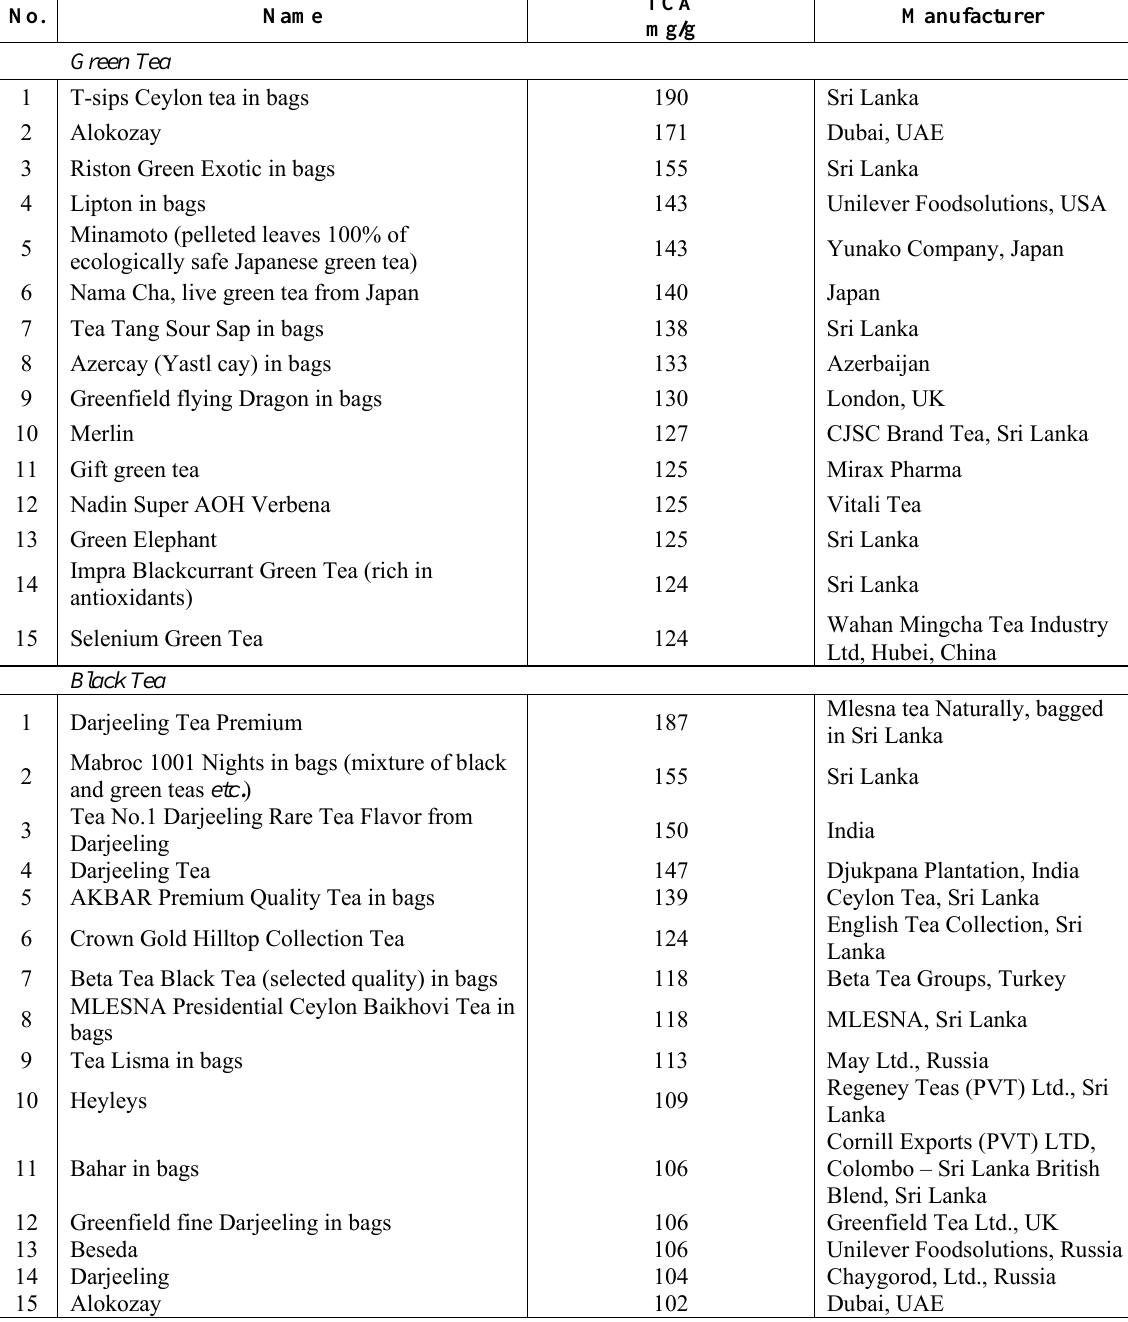
Our databank contains TCA-related data for all kinds of tea: green, oolong, black, and puer [18]. In Table 8 are presented TCA data for green and black teas. Table 10 includes data for TCA content in coffee samples. Table 8. Total Content of Antioxidants (TCA) in Green & Black Teas (standard – quercetin). No.